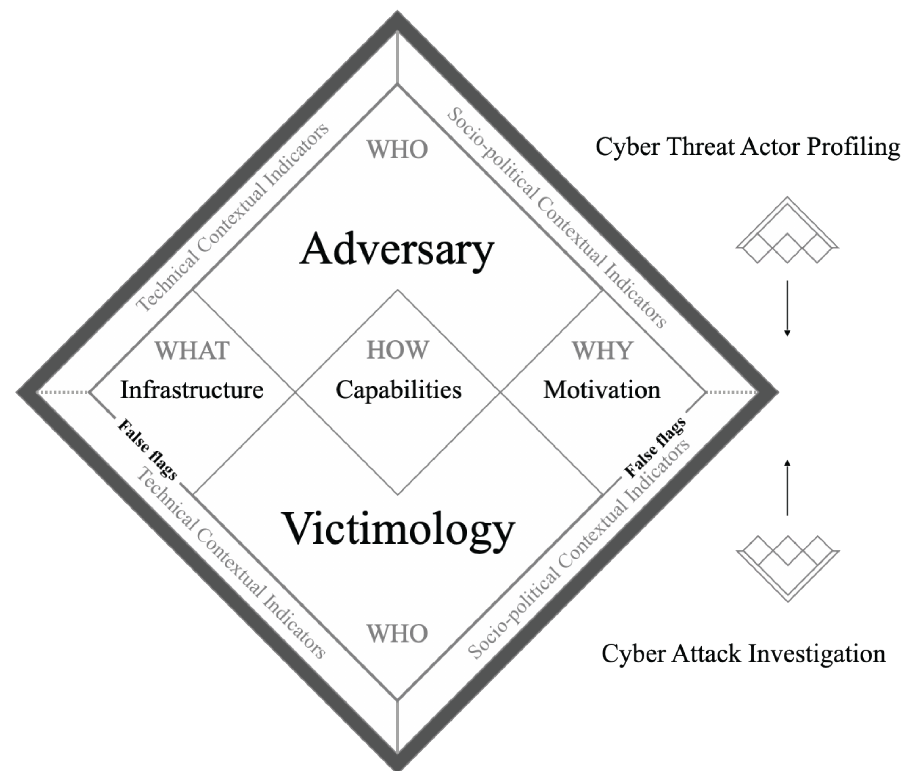
Figure 1. Cyber attribution model (CAM) presented by Pahi is a method that identifies the at- tacker [11]. CAM helps with the cyber threat actor profiling from the adversary group. It also helps with the cyber attack